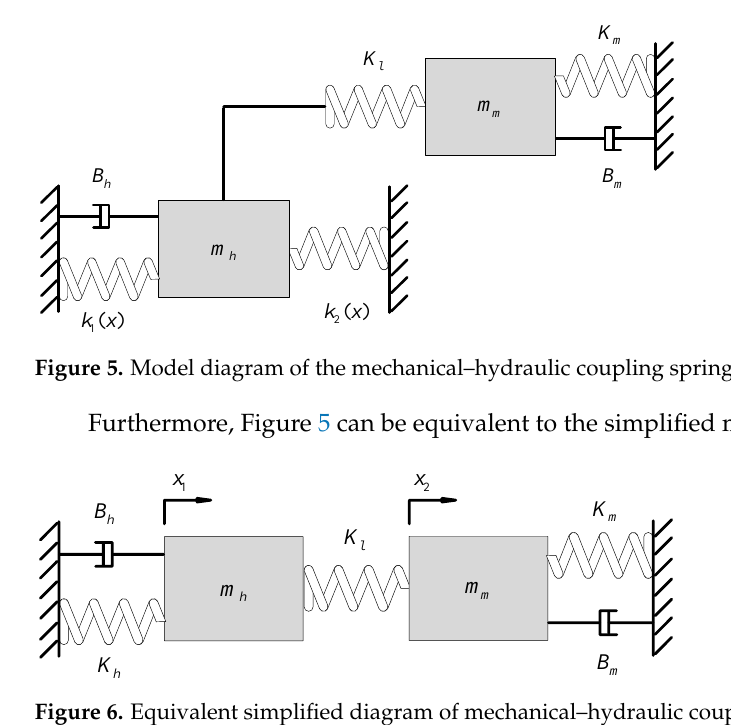
Figure 6. Equivalent simplified diagram of mechanical – hydraulic coupling spring mass model.